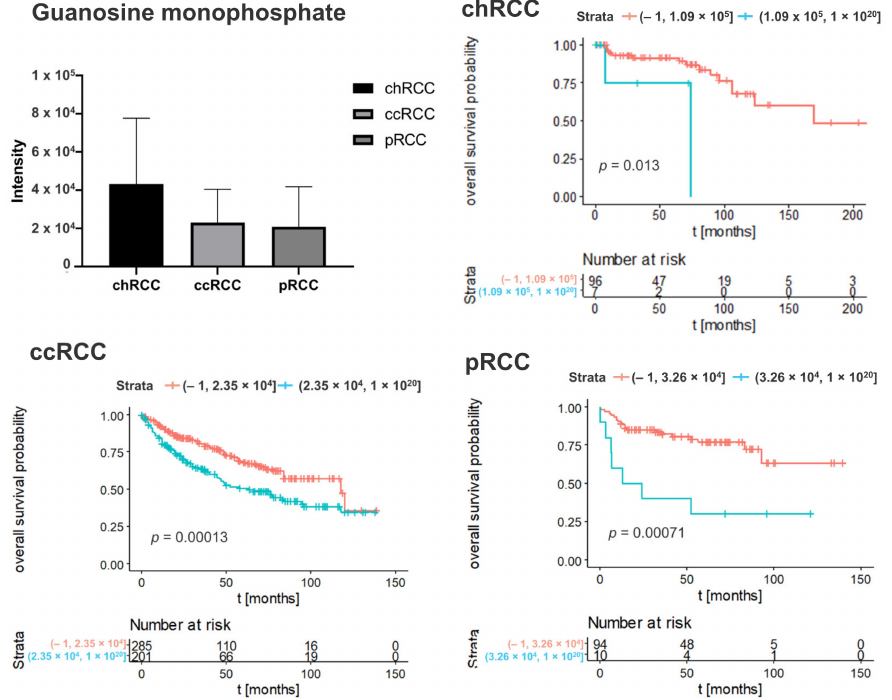
Figure 2. Kaplan–Meier curve of guanosine monophosphate in different subtypes of renal tumor. Blue lines indicate survival in patients with high intensity of the respective mass. Red lines indicate survival in patients with low intensity of the respective mass. Statistical significance testing was performed using the Kruskal–Wallis test (alpha =